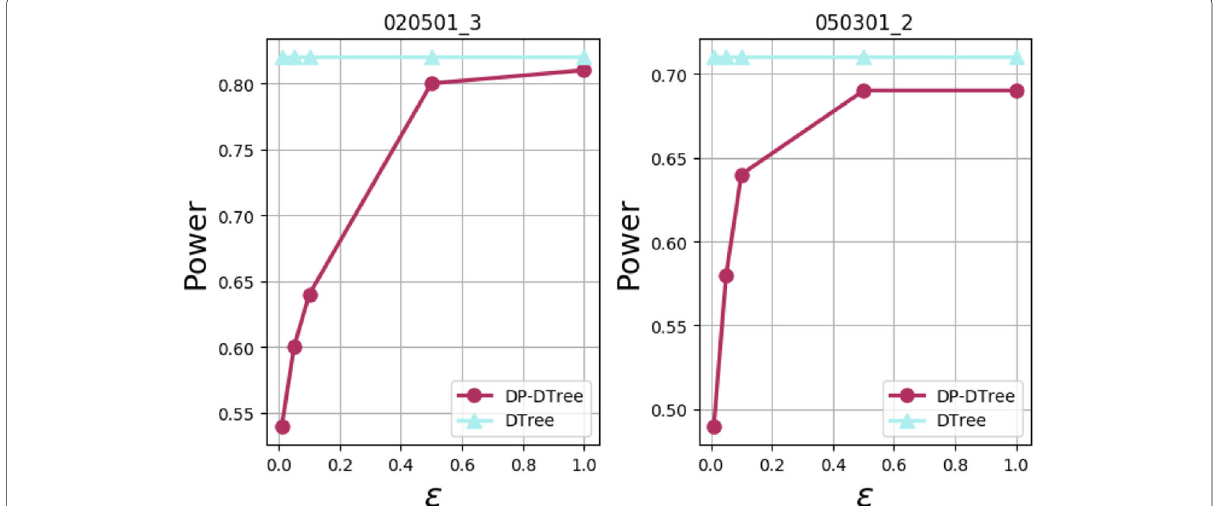
Fig. 7 Experimental results on DTree and DP-DTree( ε